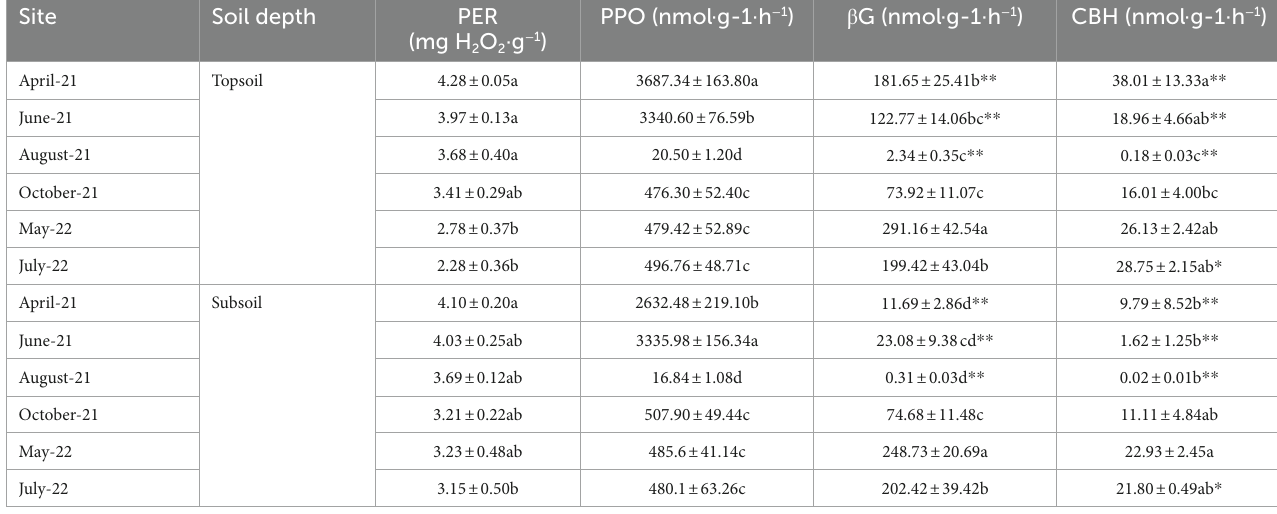
The data are expressed as the mean values ± SEs. Different letters indicate that the same variable differs significantly from month to month ( P < 0.05). * indicates that the same variable in the same month is significantly different in different soil layers ( p < 0.05). ** indicates that the same variable in the same month is significantly different in different soil layers ( p <